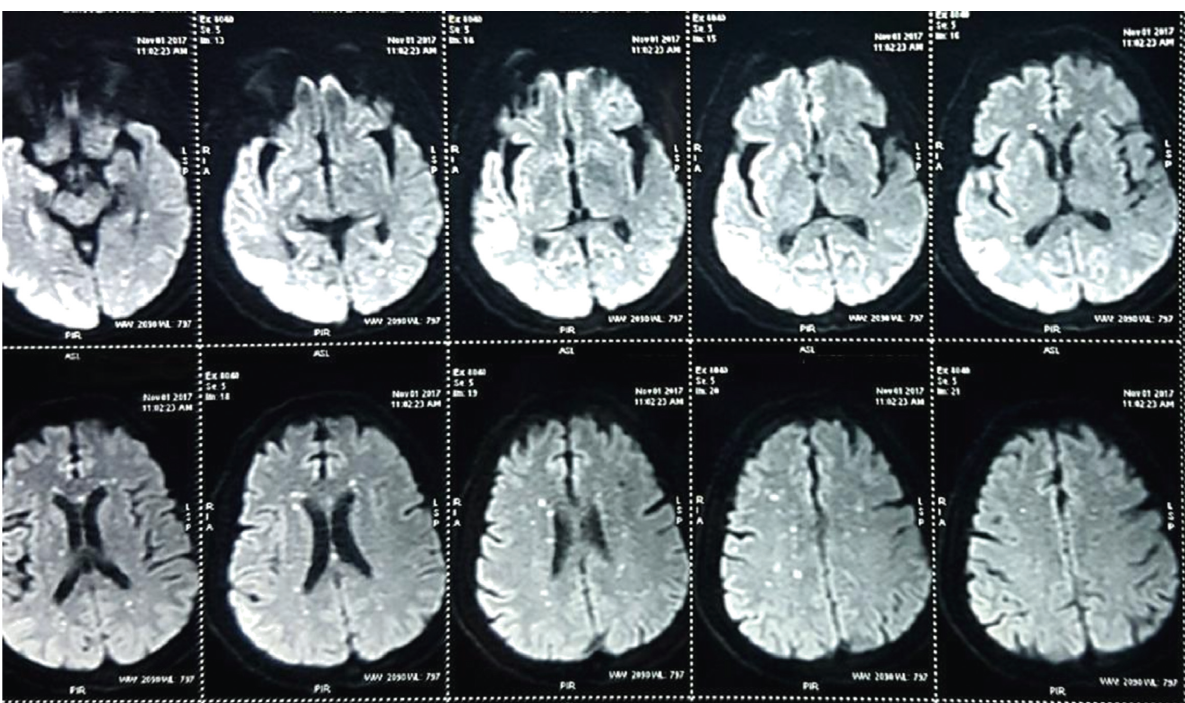
Figure 1: Multiple tiny areas with restricted diffusion in subcortical and periventricular white matter on axial DWI